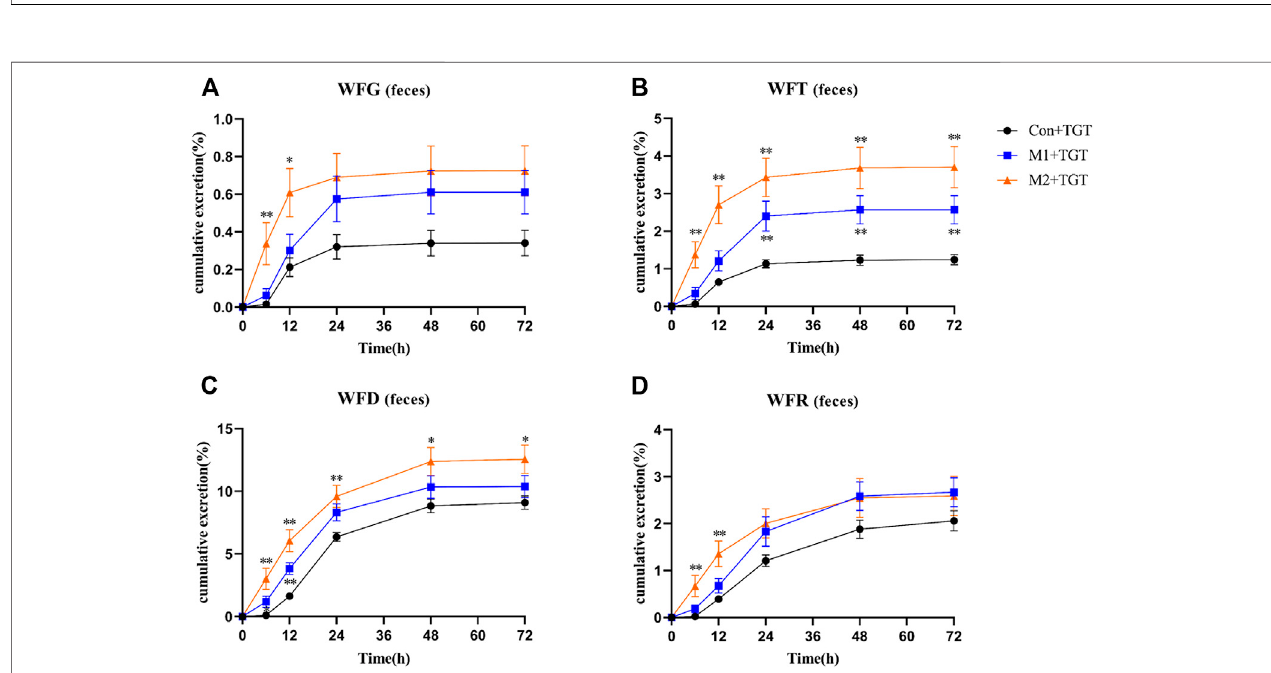
FIGURE 9 | The cumulative feces excretion ratios of the four key TGT components in the normal and two types of adriamycin-induced-NS rats after a single TGT oralgavagedoseof10 mg/kg(mean±SD, n =7).Thenormalrats,Con+TGT,blackcircle C ;theearly-stageNSrats,M1+TGT,bluesquare ;theadvanced-stageNS rats, M2+TGT, orange triangle . WFG (A) , WFT (B) , WFD (C) , WFR (D) , p p < 0.05, pp p < 0.01 versus Con + TGT.